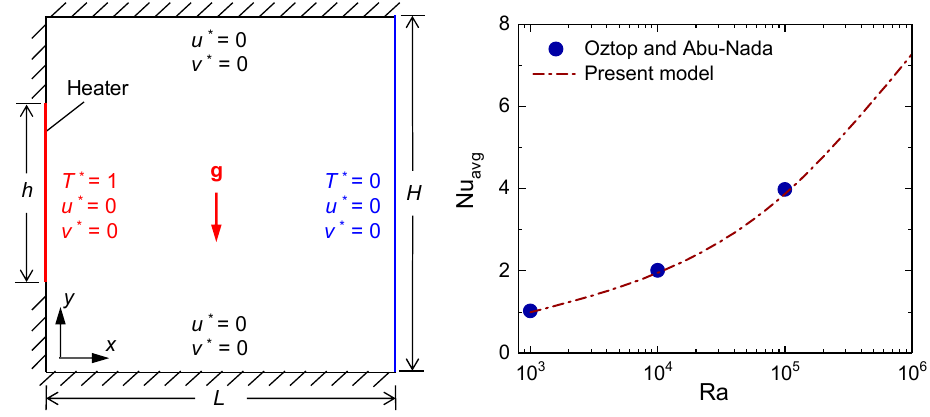
Figure 4. Schematic diagram of a partially heated rectangular cavity filled with pure fluid and the average Nusselt number (Nu avg ) as a function of Rayleigh number (Ra) for a comparison of present model data with published data for a partially heated rectangular cavity filled with pure fluid [21]. Reproduced from Ref. [39], with the permission of AIP Publishing.